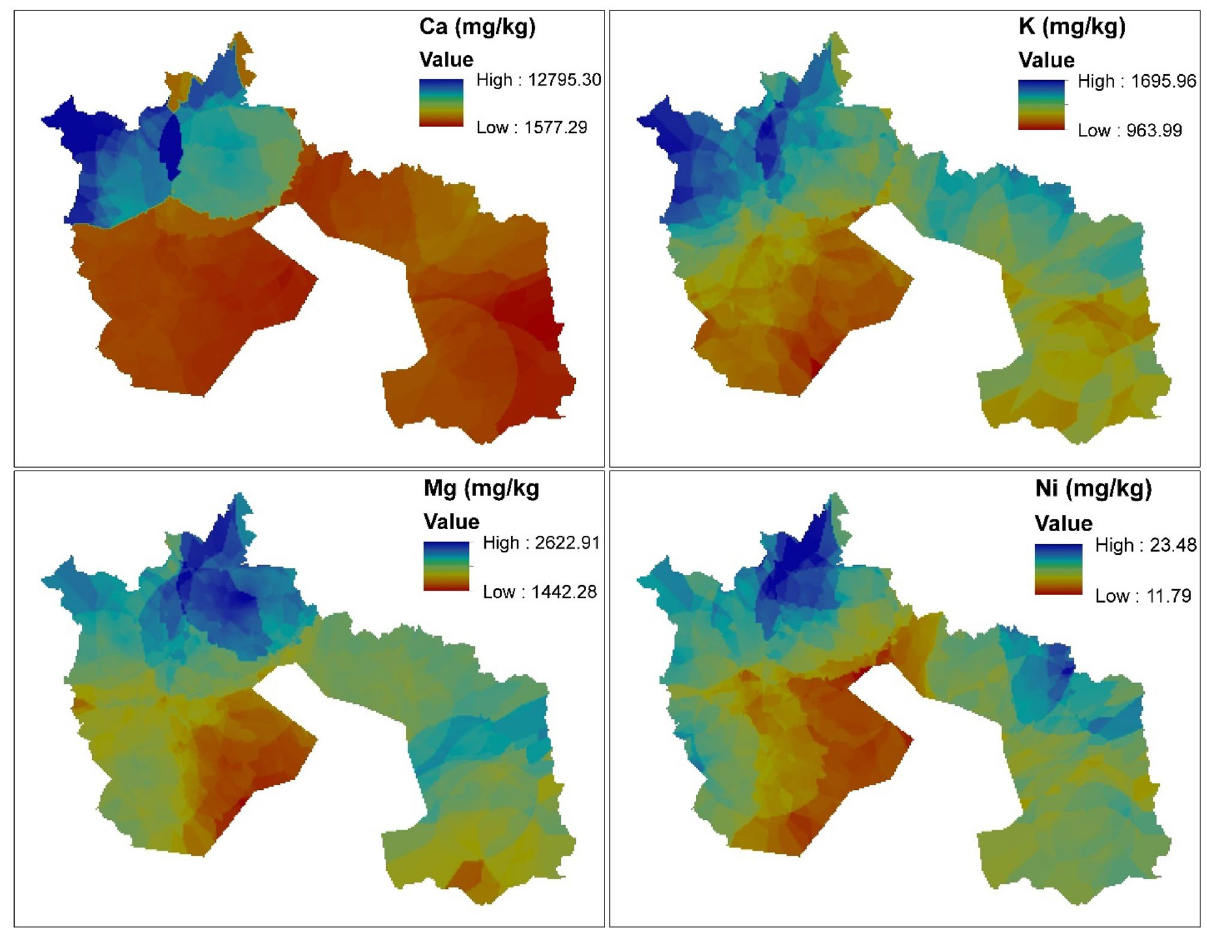
Figure 4. Spatial distribution of the elements [The spatial distribution maps was created with ArcGIS Desktop (ESRI, Inc, Version 10.7, URL: https:// deskt op. arcgis. com).]